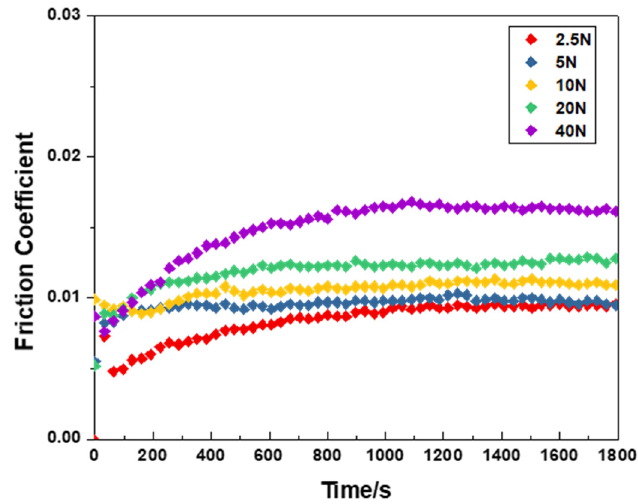
Figure 10. Friction coefficient of the composite coated Ti6Al4V versus time under different loads.